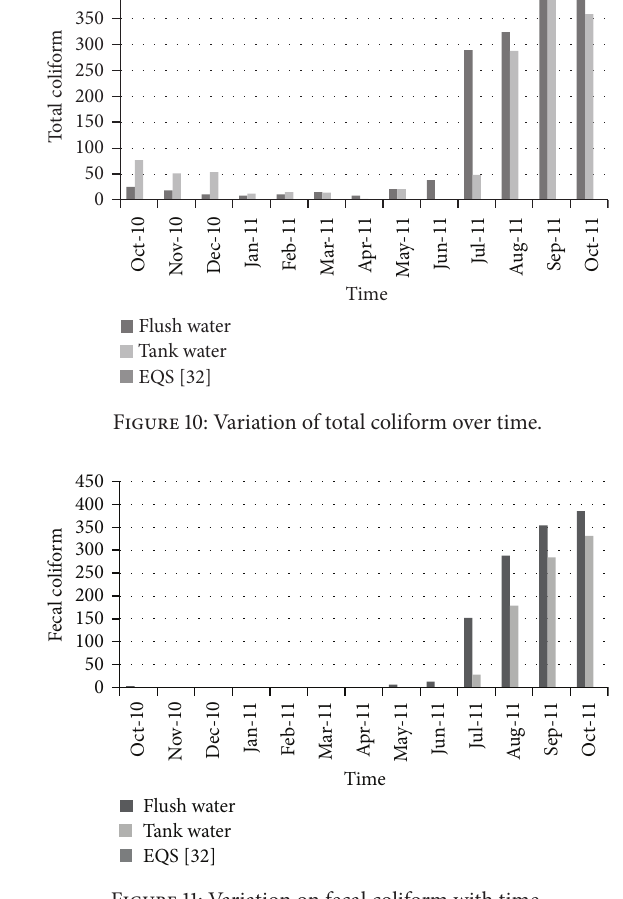
Figure 11: Variation on fecal coliform with